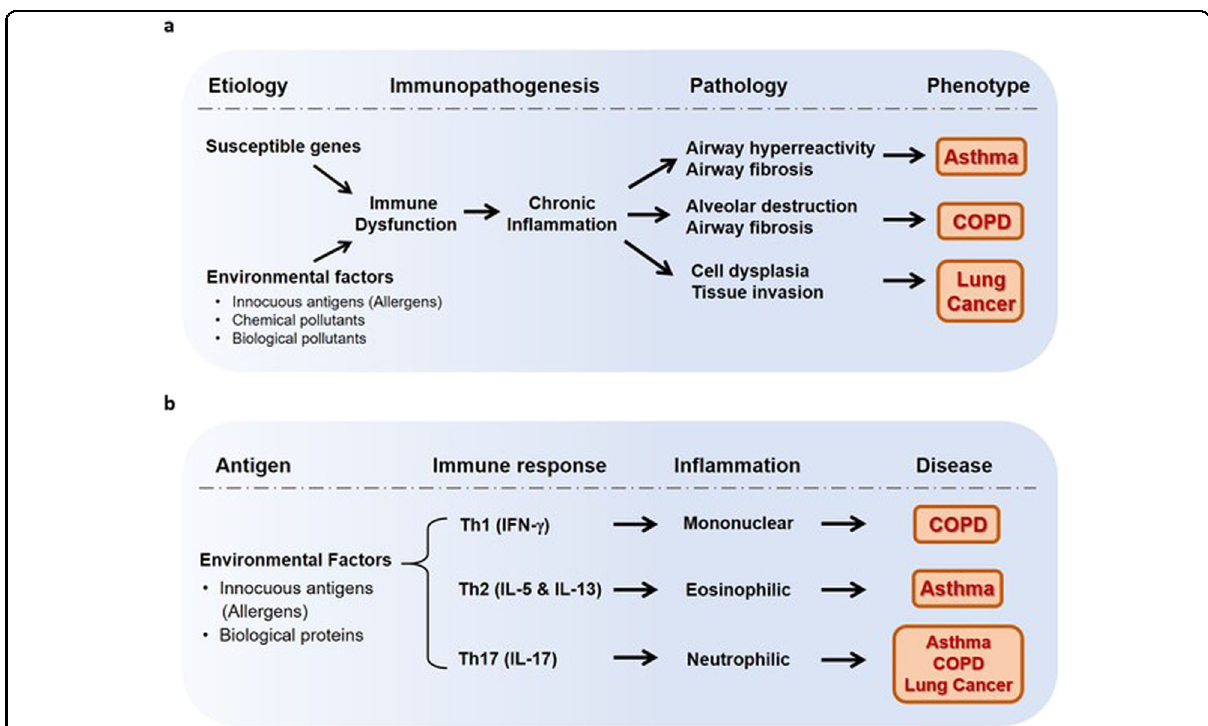
Fig. 1 Asthma, COPD, and lung cancer development is associated with chronic in fl ammation, which is a result of immune dysfunction. Immune dysfunction is induced by susceptible genes and environmental factors, such as chemical and biological substances. Biological factors including allergens and biological proteins that act as antigens induce Th1, Th2, and Th17 cell immune responses. These immune responses lead to mononuclear, eosinophilic and neutrophilic in fl ammation and contribute to the development of COPD, asthma, and lung